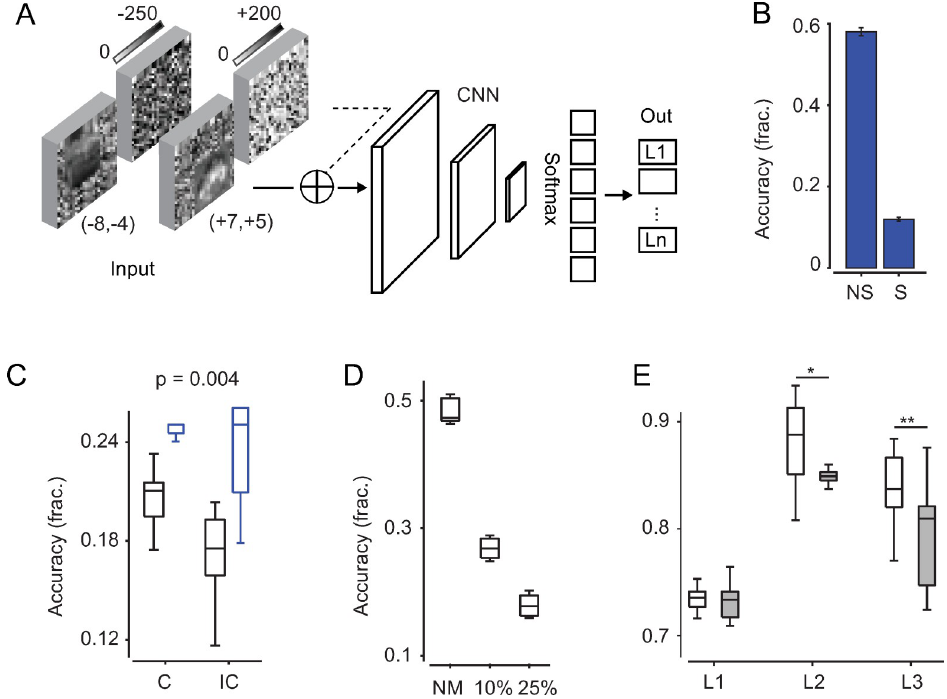
Fig 2. Eye movements support classification accuracy of image categories and saccadic directions. (A) Schematic of the network architecture. Noise-framed and shifted CIFAR-10 images were provided at the image-input layer. Value pairs in parentheses indicate the numeric amplitudes used for horizontal and vertical image shifts, relative to the center: negative values for top-left shifts, positive for bottom-right ones. Image amplitudes were in the [0,255] range. Movement inputs were also provided as images (pixel noise) with amplitude values scaled to match (with sign) the amplitude range of the images (congruent condition). In the incongruent condition, movement amplitudes were randomly assigned to shifted images. A feature layer was added to the image layer before conv-2, or other convolutional layers in control simulations. (B) Classification performance (accuracy) of CNNs trained with no saccadic shifts and tested also with no saccadic shifts (“NS” label) or with saccadic shifts (“S” label). (C) Performance of CNNs when trained with congruent and incongruent movement inputs (black boxes). Only networks that reached above chance-level performance (10%) were compared. Blue boxes for quadrupled number of training epochs. (D) Classification accuracy when training with saccadic shifts and varying amplitudes of incongruent movement inputs: zero amplitude (NM, no movements), 10% and 25% of the input-image amplitude, with 25% being the typical scaling value used in main simulations (Methods). (E) SVM classification accuracy of saccadic directions from channels’ activations in different layers; the SVM classifier was used to separate 3 conditions: 1st quadrant, 3rd quadrant, and 2nd or 4th quadrant (Methods, S2 Fig). Empty boxes for networks performing image classification above chance level (n = 16); filled gray boxes for networks at chance level (n = 14); p = 0.01 and p = 0.006 ( � , �� ) Wilcoxon rank sum